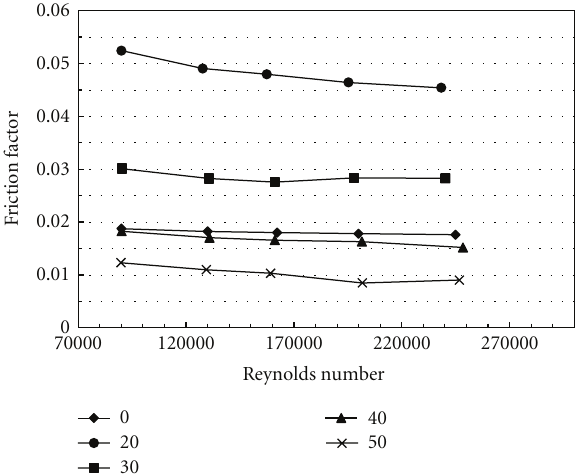
Figure 6: Friction factor for helically grooved stators at 1750 rpm versus